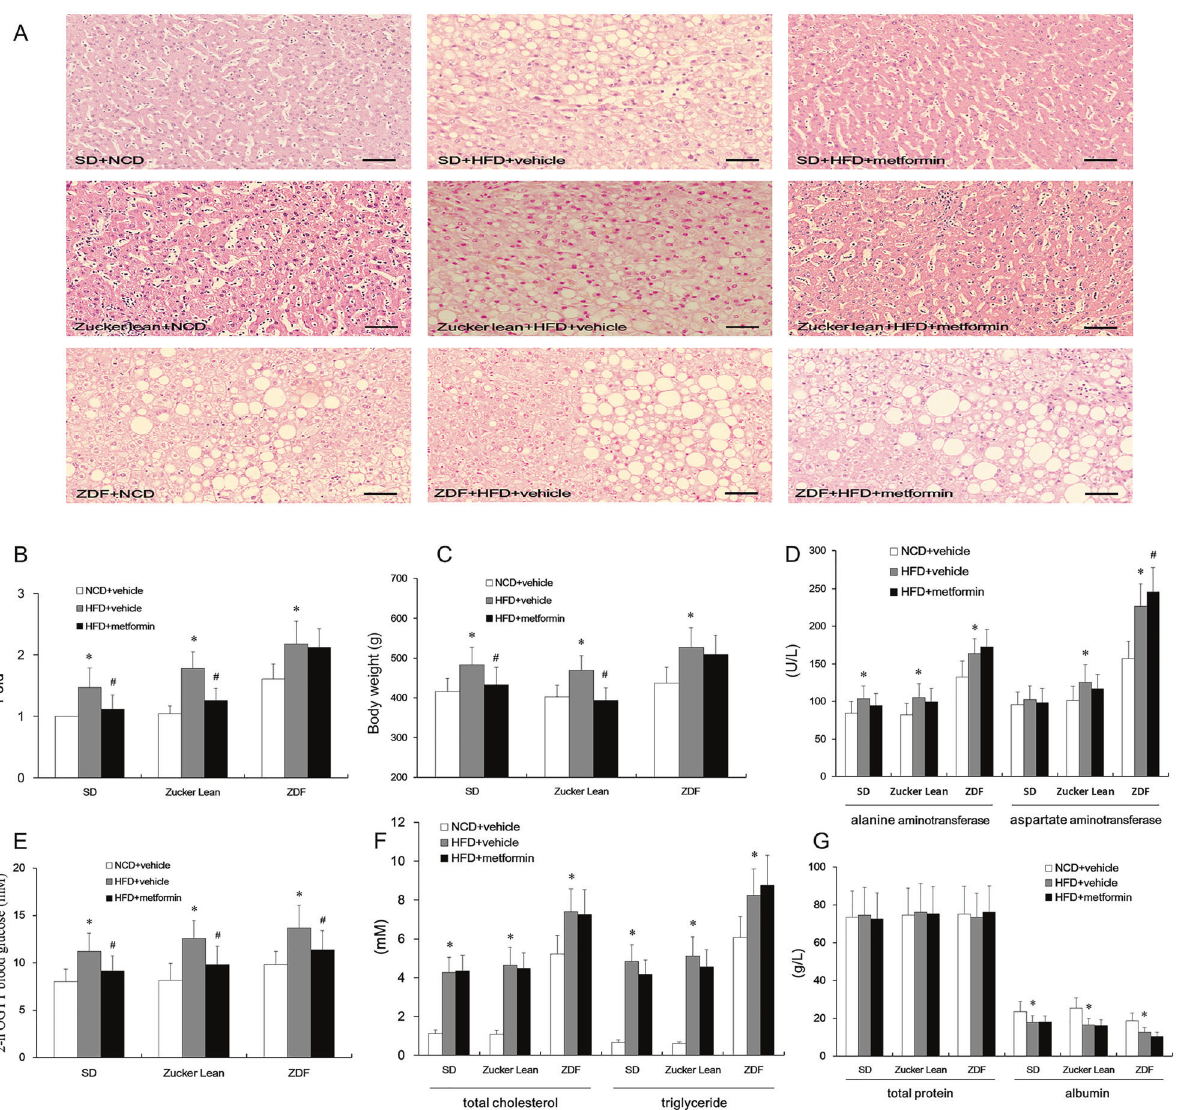
Fig. 1 Liver histology and function assessment in Zucker diabetic fatty (ZDF) rats and controls (with and without 6 months of metformin administration). A HE staining. Scale bars, 25 μ m. B Hepatocytes ’ diameter multiples in high-fat diet induced NAFLD. n = 12. * p < 0.05 vs. normal chow diet (NCD) + vehicle; # p < 0.05 vs. high-fat diet (HFD) + vehicle. C Body weight. n = 12. * p < 0.05 vs. NCD + vehicle; # p < 0.05 vs. HDF + vehicle. D Detection of alanine aminotransferase (ALT) and aspartate aminotransferase (AST). n = 12. * p < 0.05 vs. NCD + vehicle; # p < 0.05 vs. HFD + vehicle. E Detection of 2-h OGTT blood glucose. n = 12. * p < 0.05 vs. NCD + vehicle; # p < 0.05 vs. HFD + vehicle. F Detection of blood total cholesterol and triglycerides. n = 12. * p < 0.05 vs. NCD + vehicle. G Quantitation of total protein and albumin in the peripheral blood. n = 12. * p < 0.05 vs. NCD + vehicle; # p < 0.05 vs. HFD +